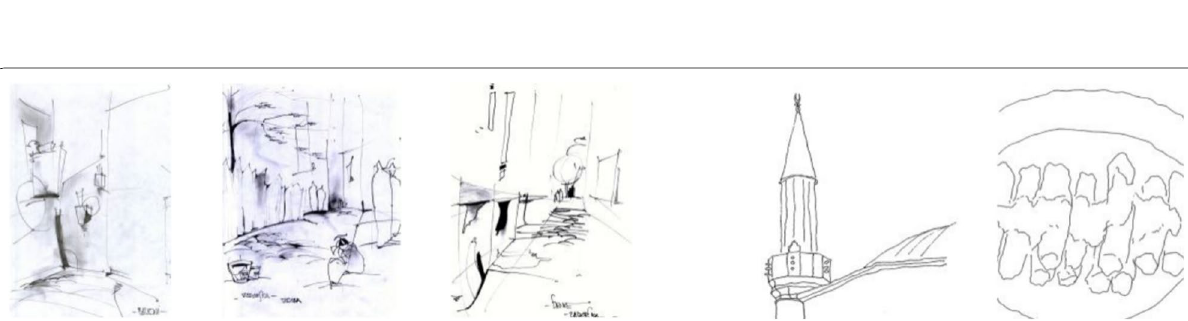
Fig. 13 Experience of urban sparks in Kosančićev venac—inhabitant (left) and visitor